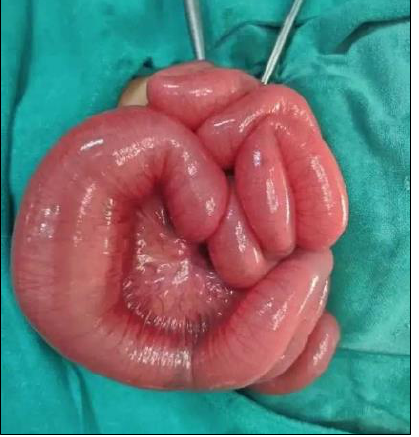
Figure 2: Shows hugely dilated distal segmental je- junum with dilated ileum.